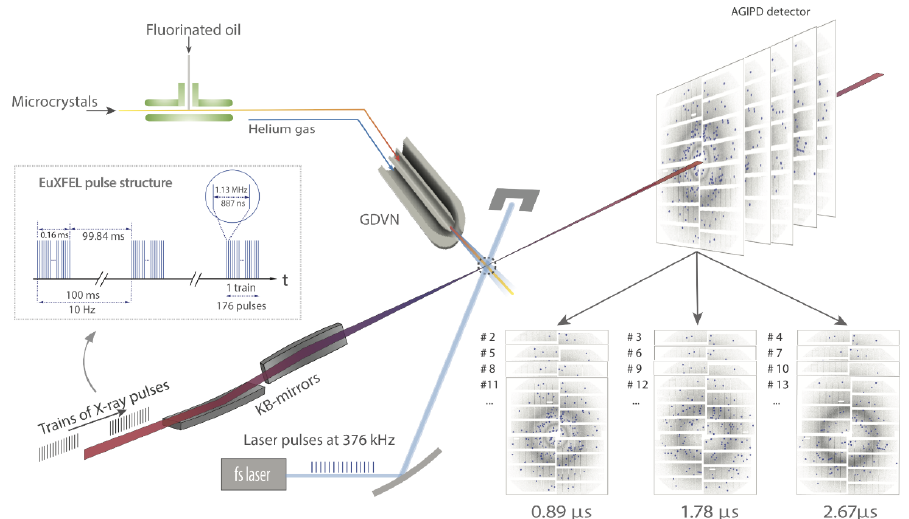
Figure 4. Pump–probe experiment at the European X-ray free electron laser (XFEL). The crystal slurry is applied with a few percent of fluorinated oil that is added by a T-junction. Crystals are excited by several hundred kHz of blue femtosecond laser pulses before they are probed by X-ray pulses. The X-ray pulse sequence is organized in trains and is shown in the inset. The Adaptive Gain Integrating Pixel Detector (AGIPD) collects the diffraction patterns, which will be sorted based on the pulse ID (arrows). The figure is from Pandey et al. [66].